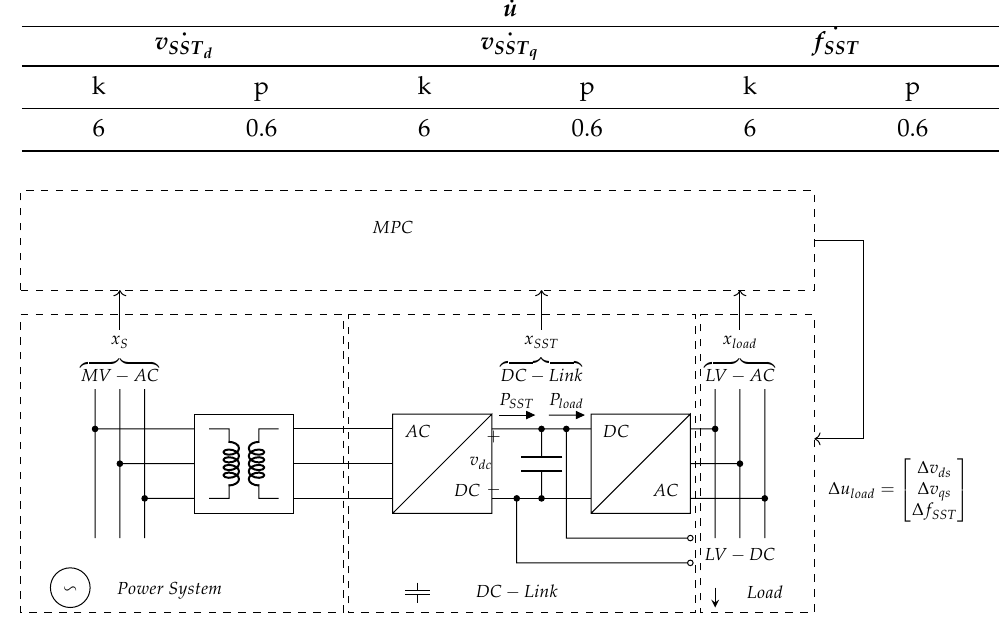
Figure 6. Circuit diagram for the implementation proposed predictive control-based frequency- responsive